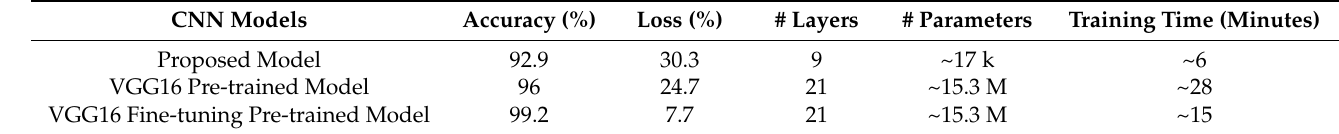
Table 2. Comparison of the test accuracy and loss for the CNN-based